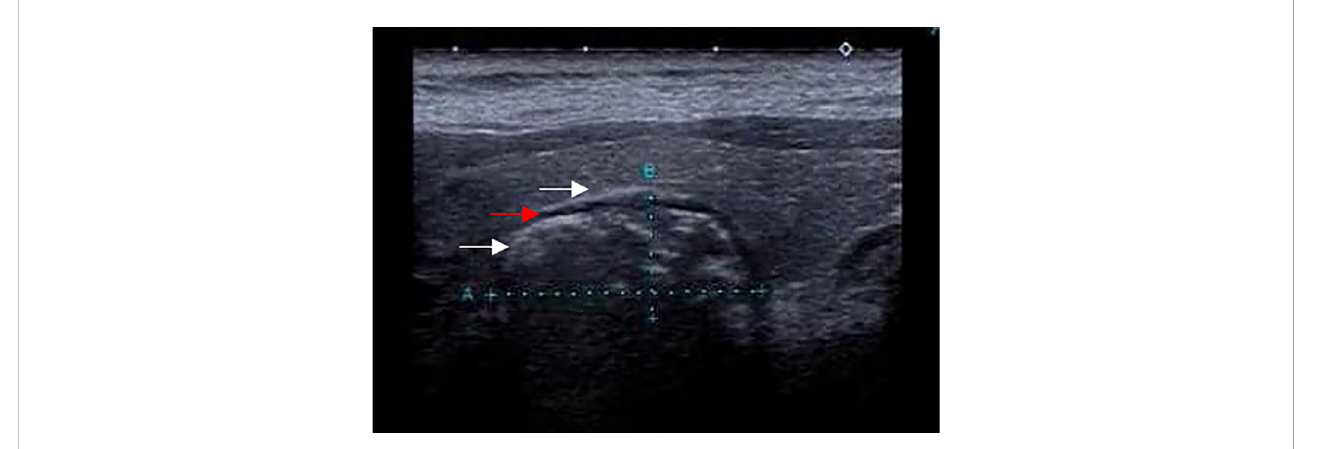
FIGURE 3 The solid nodular diverticulum wall has a typical hyper-hypo-hyper echogenic pattern (image from a 37-year-old woman).